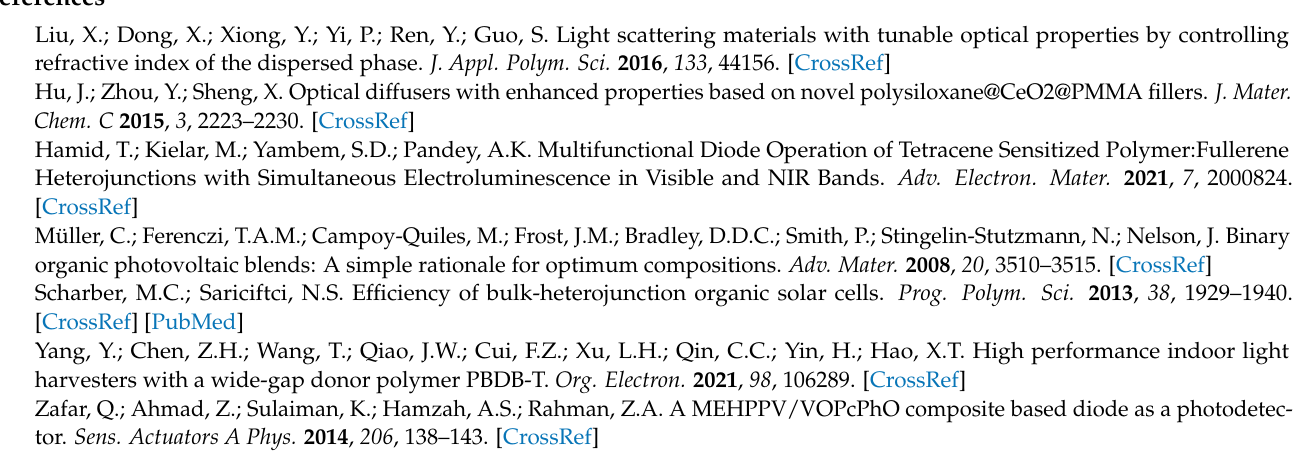
experimental setup used for RL measurements, Figure S3: AFM images and surface profiles, Figure S4: Height histograms, Figure S5: Flooding